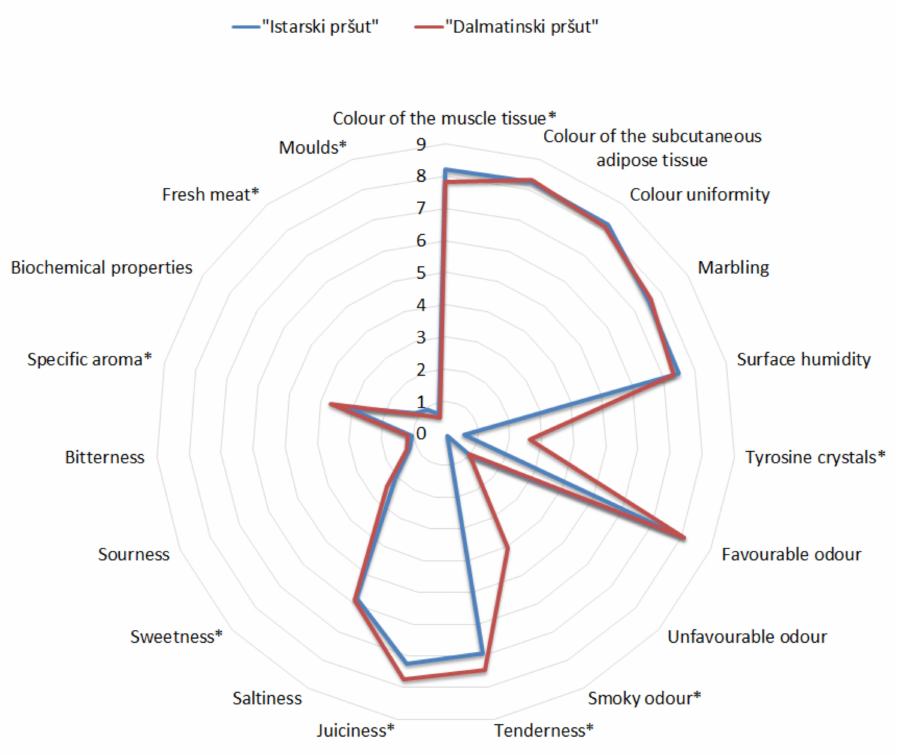
Figure 1. Sensory characteristics of “Istarski pršut” and “Dalmatinski pršut” (appearance, odour, texture, taste, and aroma). * statistically significant difference; numerical scale of intensity of sensory properties: “0” indicates the absence of a given sensory property, and “9” indicates its strongest